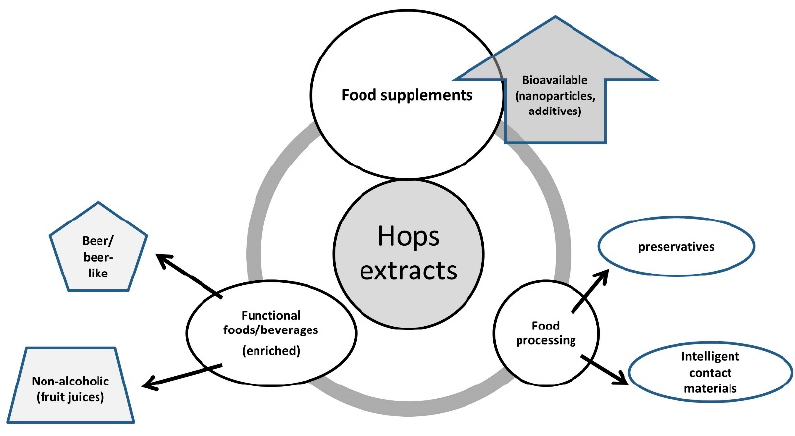
Figure 4. Perspectives for hops based products.